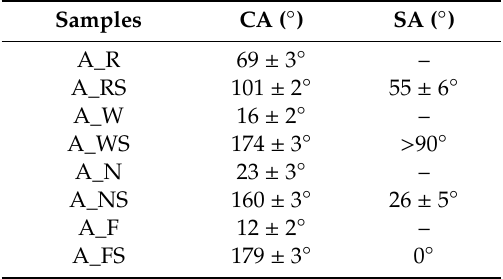
Table 3. Summary of water contact and sliding angles at AA6082 surfaces after different treatment steps.